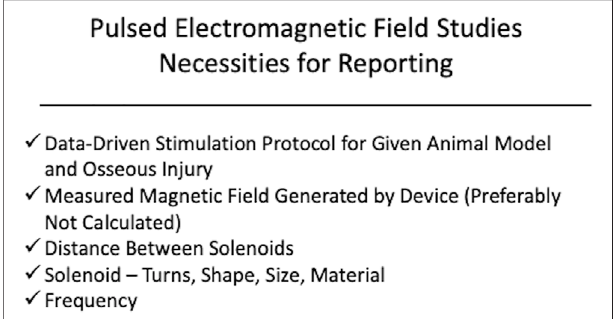
FIGURE 3 | Displayed is a schematic of the recommended components of device speci fi cations and stimulation protocol for pulsed electromagnetic frequency. The authors recommend reporting a measured magnetic fi eld strength, frequency, and solenoid parameters (turns, size, shape). It is also recommended that the stimulation protocol be derived from previous studies demonstrating bene fi t of the ES modality within the context of the osseous injury being